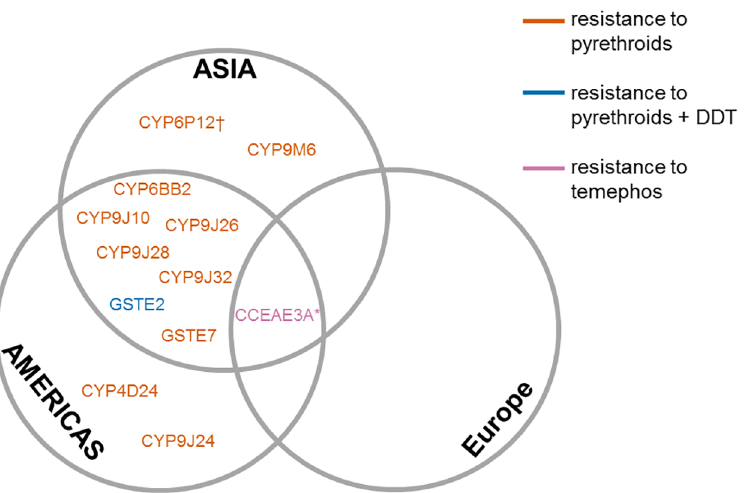
Fig 6. The geographical distribution of metabolic resistance detoxification genes based on significant overexpression. Genes are shown if linked to a resistance phenotypein transcriptomic studies, and a role has been demonstrated by functionalvalidation (in vitro metabolism, ribonucleicacid interference (RNAi), or heterologous expression). All are in Ae . aegypti other than those marked: † Ae . albopictus ; * both